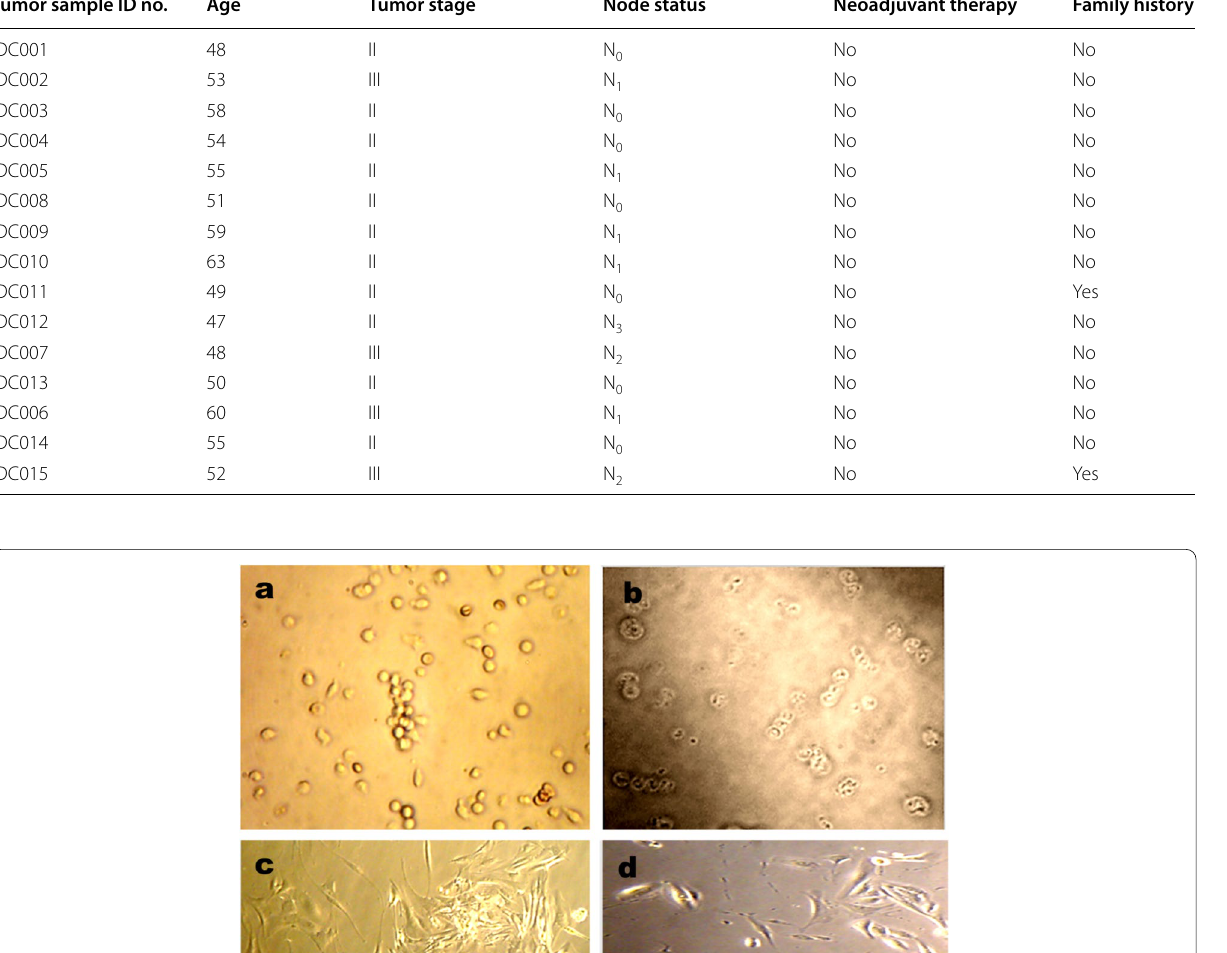
Table 1 Clinicopathological parameters of breast cancer subjects Tumor sample ID no.